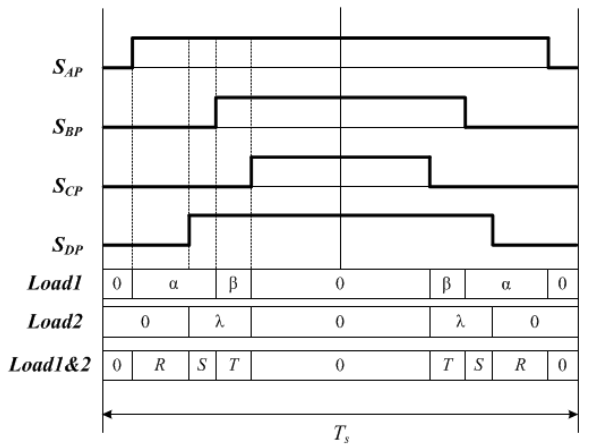
Figure 6. Switching state of the inverter stage considering the three-phase output and single-phase output. The combination of the switching patterns of the rectifier stage and the inverter stage for the dual outputs is shown in Figure 7. The inverter stage is switched both into the free-wheeling operation and the rectifier stage, and then, it is commutated at the zero DC-link current. It can also be seen that the inverter stage switching frequency is two times the rectifier stage switching frequency.